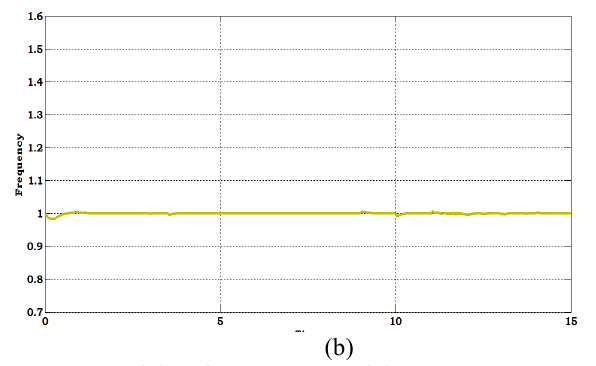
Figure 11. (a). DC link voltage, (b).Frequency Other units are suddenly connected at t=12sec, hence